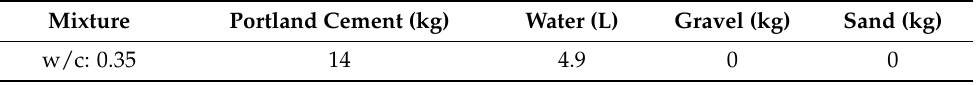
Table 2. Content by m 3 of concrete for X-ray diffraction analysis and measuring of hydration heat.